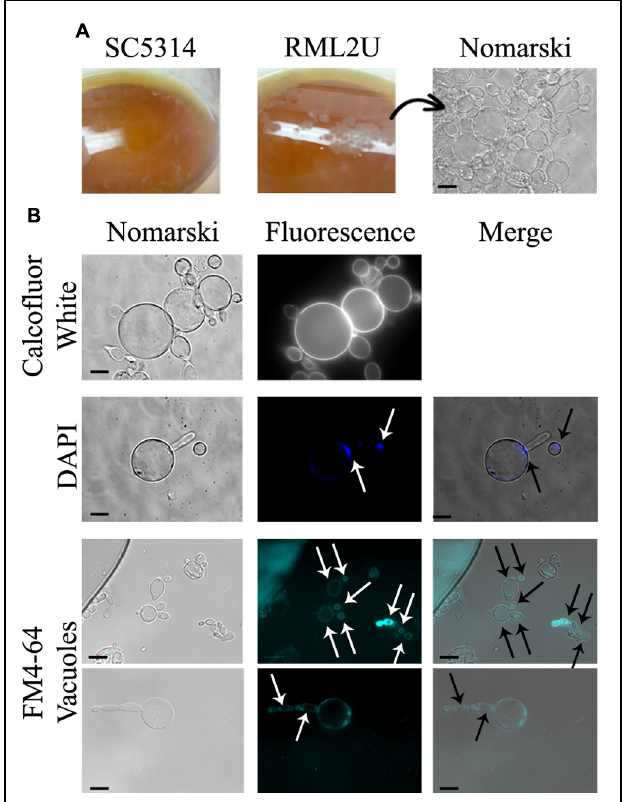
FIGURE 4 | Novel C. albicans “veil growth.” (A) “Veil growth” was observed in stationary and static RML2U cultures and not in those of SC5314. (B) Different cell stainings were performed to clarify chitin distribution (calcofluor white staining), nuclear DNA composition (DAPI labeling) and to locate each cell vacuole (FM4-64).